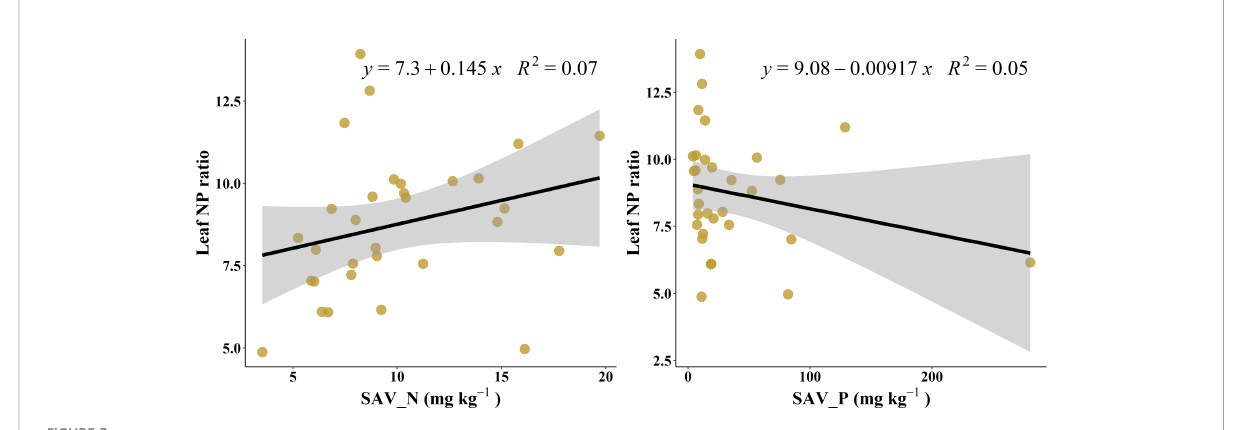
FIGURE 3 Correlation of leaf NP ratio with soil available